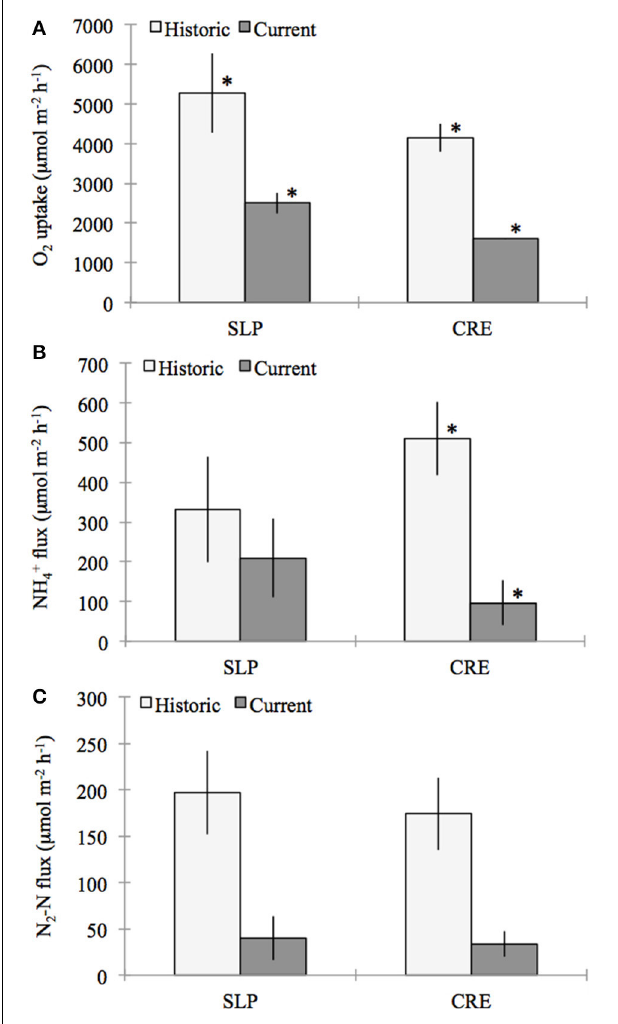
FIGURE 4 | Comparison of historic (July–October, 1992–1994) (LaMontagne, 1996) and current (July–October, 2011–2012) benthic flux rates of (A) oxygen (O 2 ), (B) ammonium (NH + 4 ), and (C) di-nitrogen gas per mole nitrogen (N − 2 N) (for direct measurements made from sealed cores collected from Sage Lot Pond (SLP) and Childs River Estuary (CRE) in Waquoit Bay. Bars represent station means ( ± standard error) from incubation dates (SLP Historic n = 4, SLP Current n = 3 except